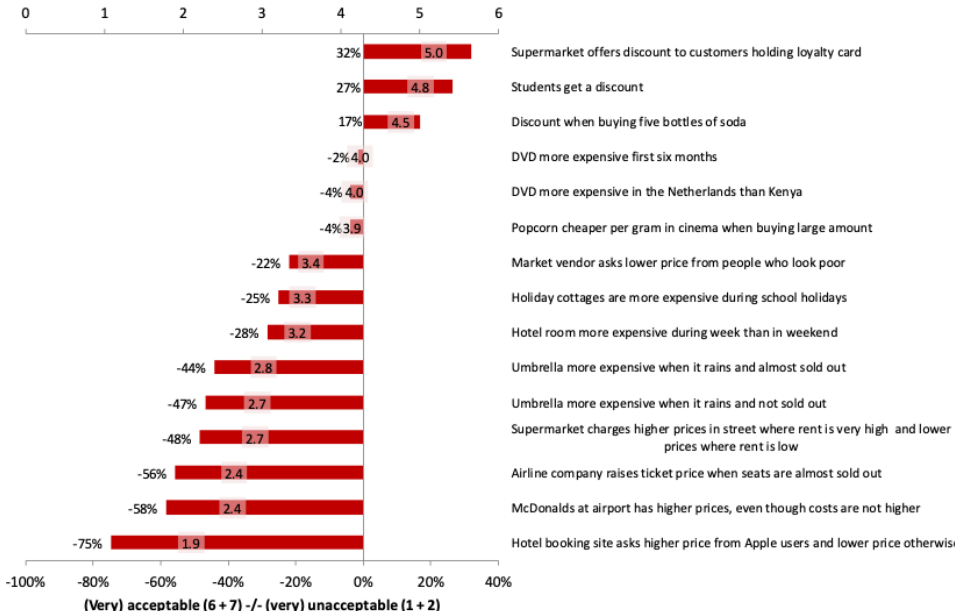
Figure 8: Net acceptability of different forms of price discrimination and dynamic pricing